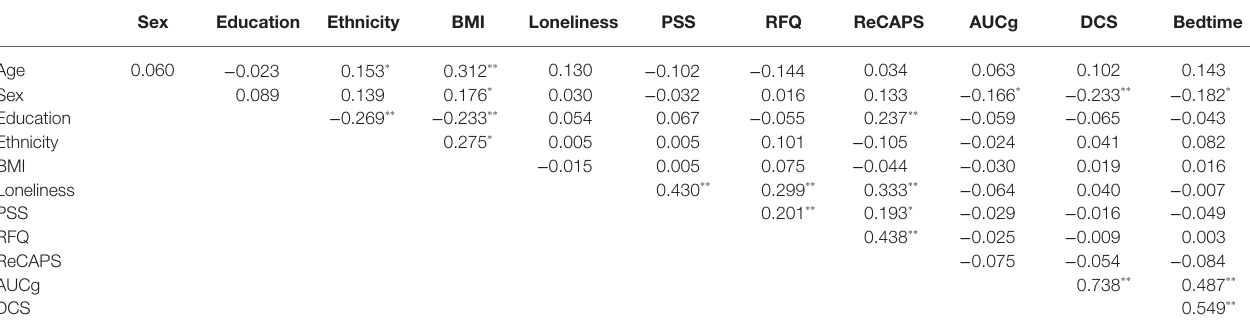
TABLE 2 | Pearson’s correlations between all variables